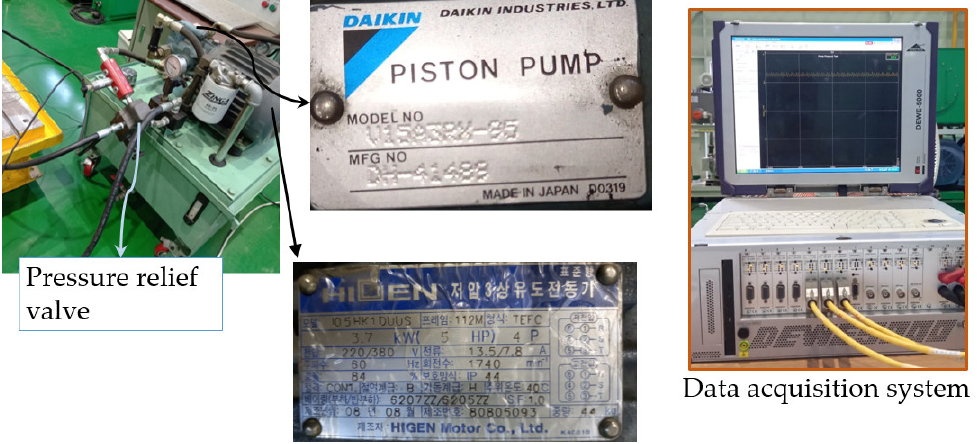
Figure 4. Equipment used for pump pressure measurement.